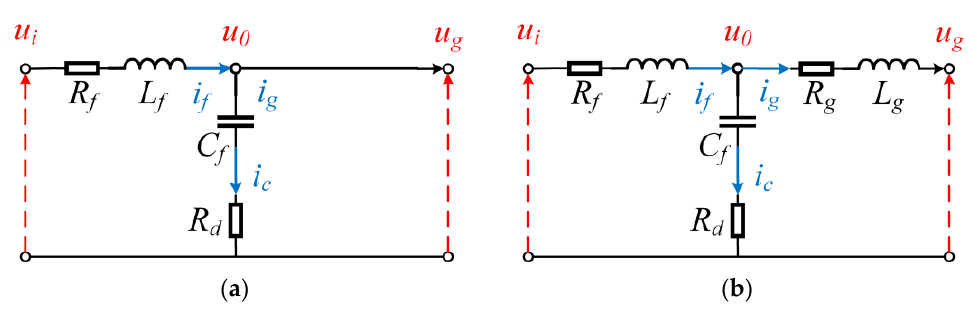
Figure 14. The LC low-pass filter schematics: ( a ) without transformer; ( b ) with transformer acting as the load-side inductor and forming the resulting LCL-type filter. Table 4. The LC filter